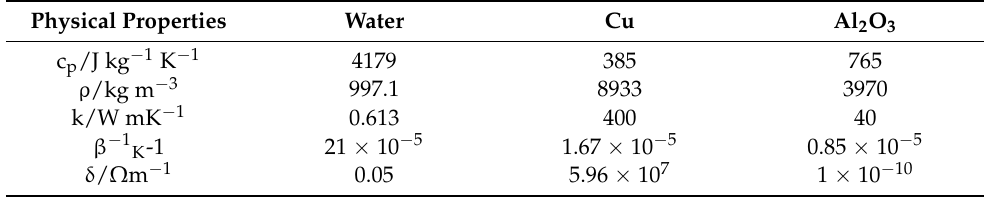
Table 3. Physical properties of water and nanoparticles [46].